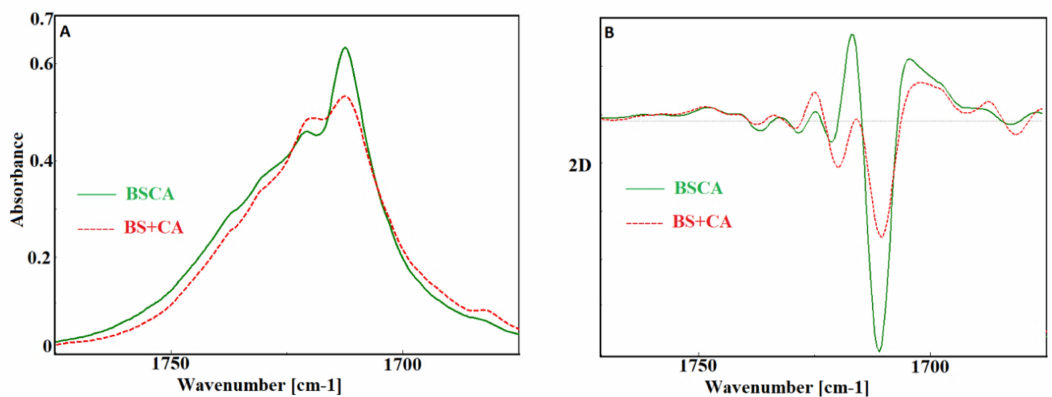
Figure 7. FTIR spectrum of oligomer BSCA and sum of BS and CA spectra ( A ) and their second derivative spectra ( B ).